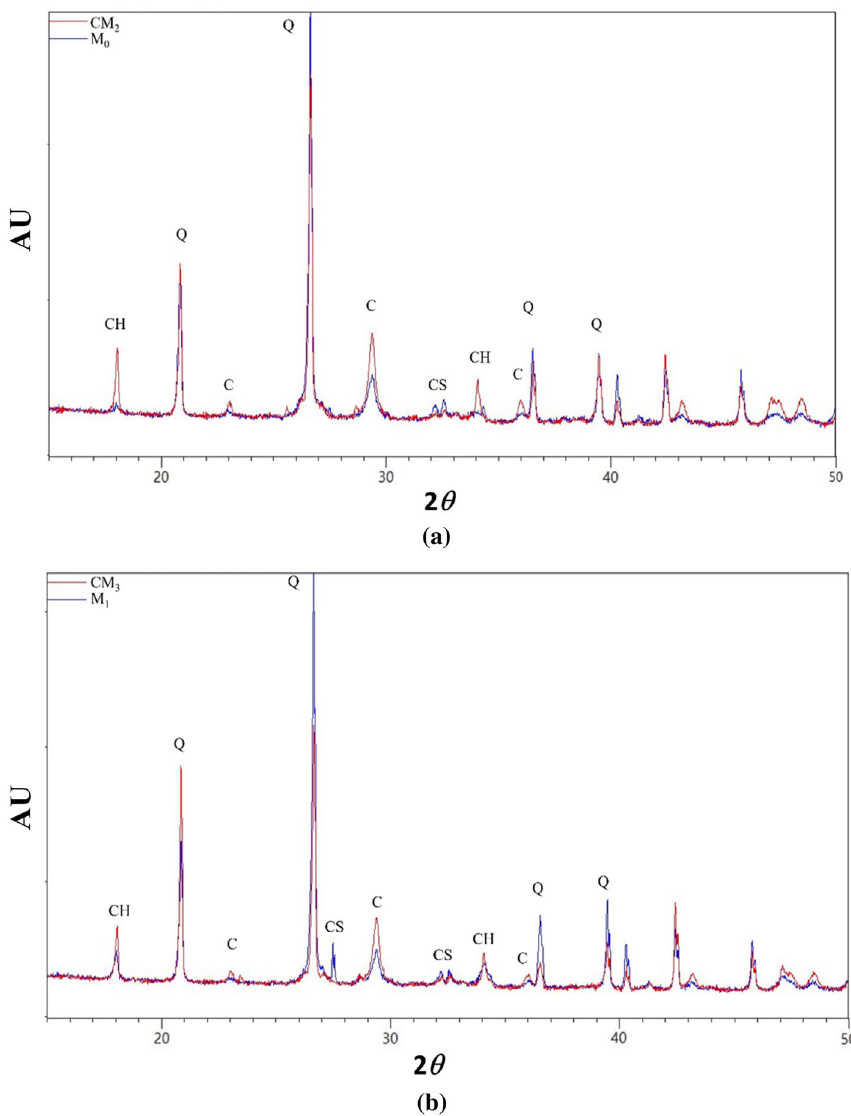
Figure 3. X-ray diffraction spectra of mortar samples after the hydration process (CH is for calcium hydroxide, C for calcium carbonate, CS for calcium silicate and Q is for quartz mineral